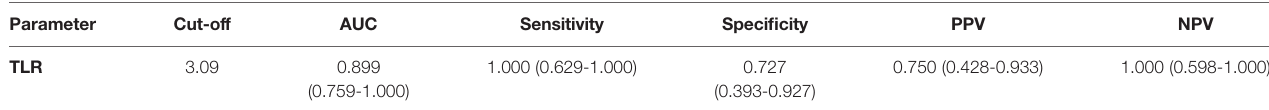
TABLE 3 | Differential diagnostic ef fi ciency of TLR between responders and non-responders. Parameter